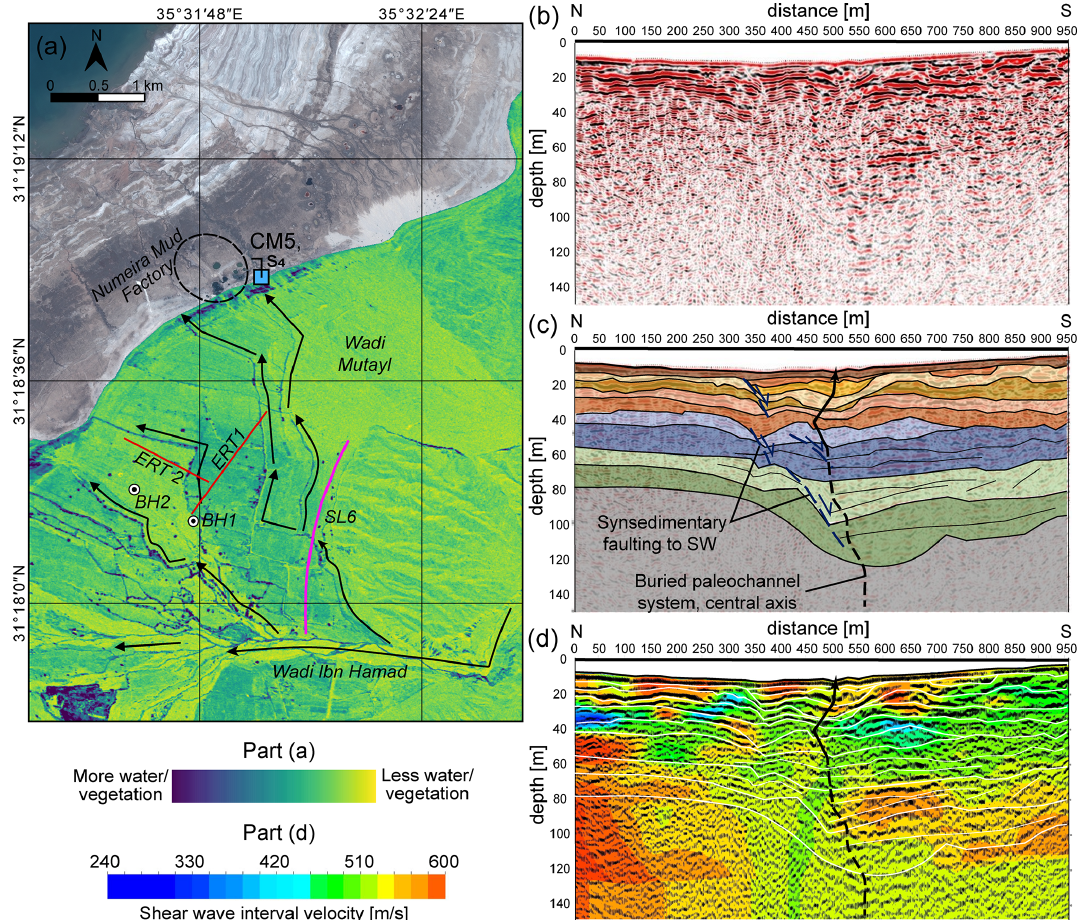
Figure 12. Evidence of water flow in sediments of the Wadi Ibn Hamad alluvial fan as deduced from aerial photos and reflection seismic profile 6 connected to stream channel CM5. (a) Coloured Corona satellite image from 1970 overlain on a 2018 Pleiades satellite image, depicting the former surface channel network in the alluvial fan deposits. Water content and vegetation appear in blue (modified after Al- Halbouni et al., 2017). Flow directions in the areas of elevated water content, as determined from the hydraulic gradient toward the Dead Sea, are highlighted by arrows to the right of the flow pathways. (b) Shear wave reflection seismic profile 6 along the Amman–Aqaba highway near Ghor Al-Haditha (cf. Fig. 2). (c) Structural interpretation of seismic profile 6; analysis is described in Polom et al. (2018). Structures associated with development of a former channel system are recognized in the central part. (d) Shear wave interval velocity overlain on reflection profile